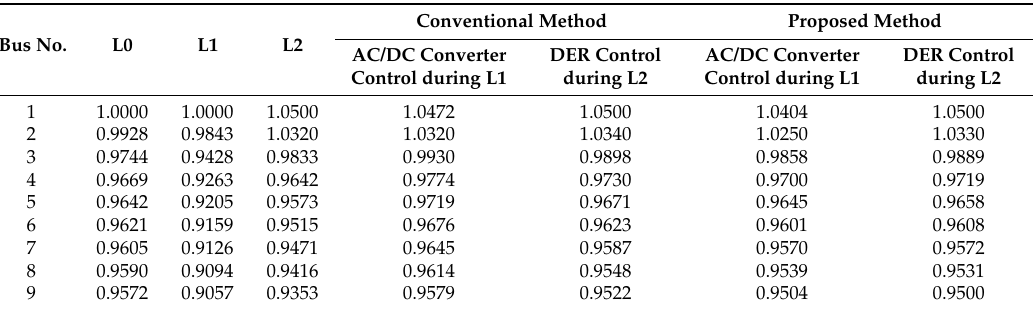
Table 5. The results of voltage profile for case 2 (Unit: per